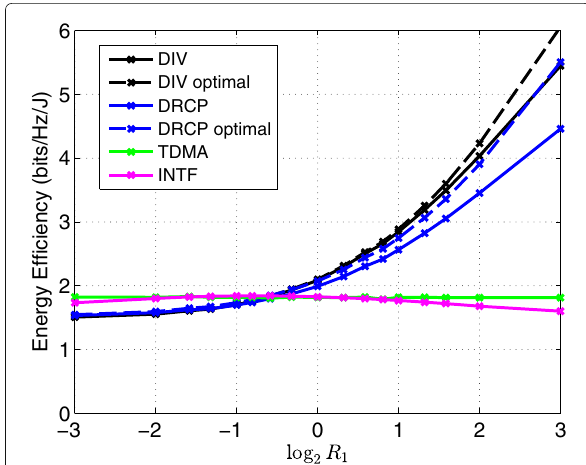
optimizing the energy efficiency in the transmit power-